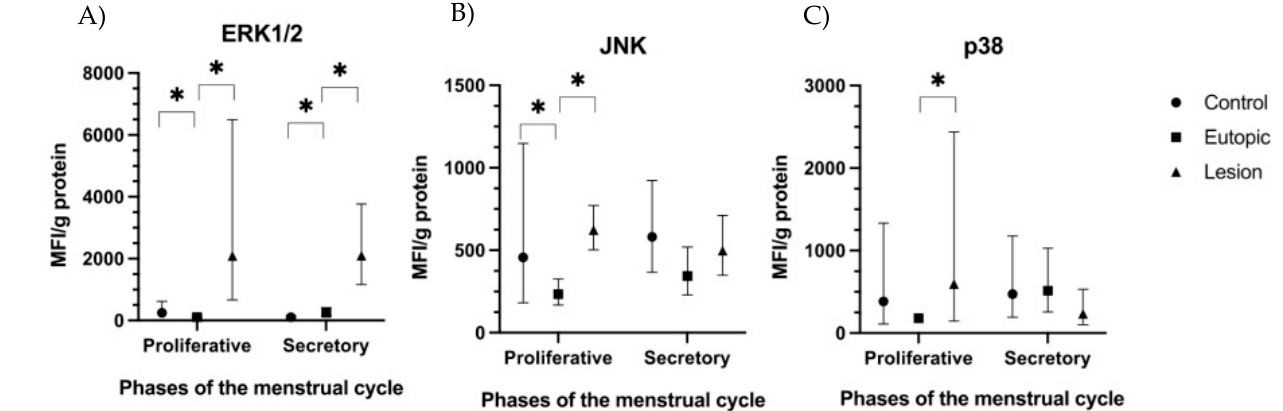
Figure 2. Concentrations of MAPK pathway proteins in tissue samples (lesion, eutopic endometrium, and non-endometriosis control) from patients with and without endometriosis (secretory and proliferative phases). Data are expressed as estimated mean values and 95% confidence intervals. ( A ) ERK1/2; ( B ) JNK; and ( C ) P38. * p < 0.05. ERK: extracellular signal-regulated kinases; JNK: c-Jun NH2-terminal kinase.